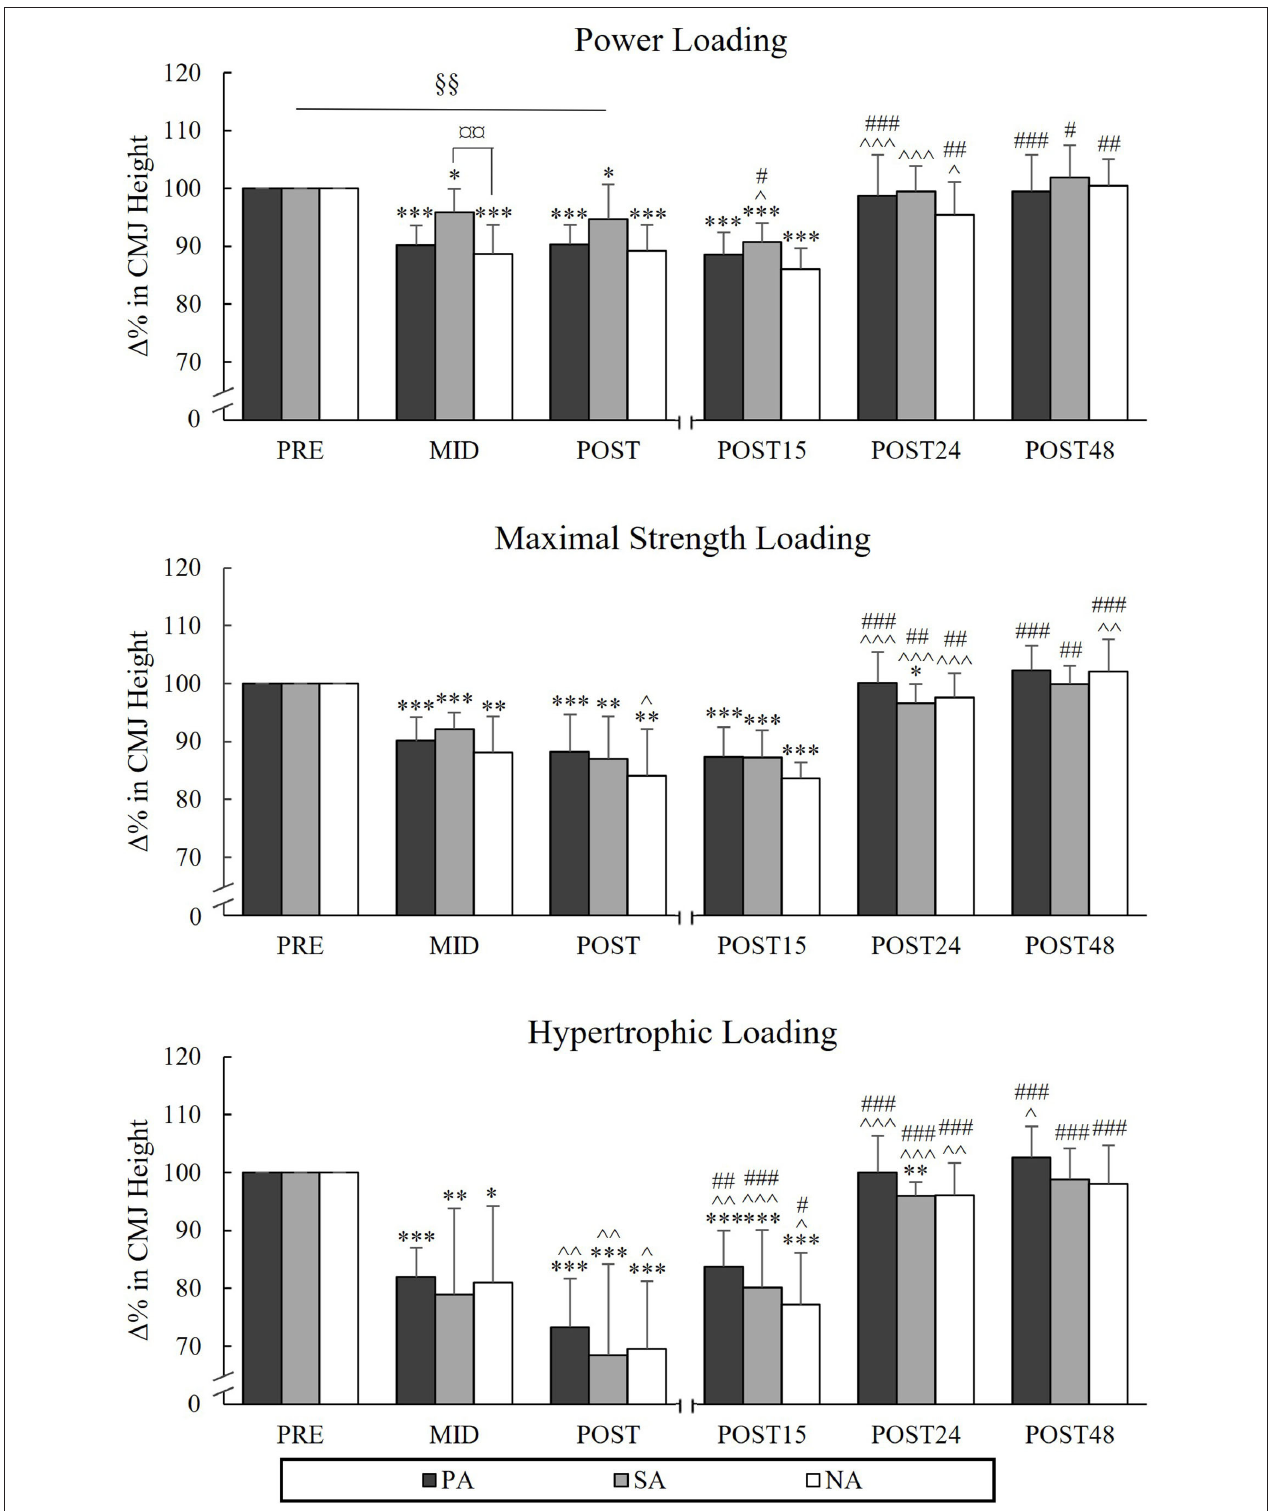
FIGURE 8 | Relative changes in CMJ height during three resistance exercise loadings in power (PA), strength (SA), and non-athletes (NA). * p < 0.05, ** p < 0.01, *** p < 0.001 refer to within-group significances compared to Pre. ∧ p < 0.05, ∧∧ p < 0.01, ∧∧∧ p < 0.001 refer to within-group significances compared to previous time point. # p < 0.05, ## p < 0.01, ### p < 0.001 refer to within-group significances compared to Post during recovery. §§ p < 0.01 refers to significant group × time point interaction from Pre to Post. ¤¤ p < 0.01 refers to a significant group difference between NA and SA.